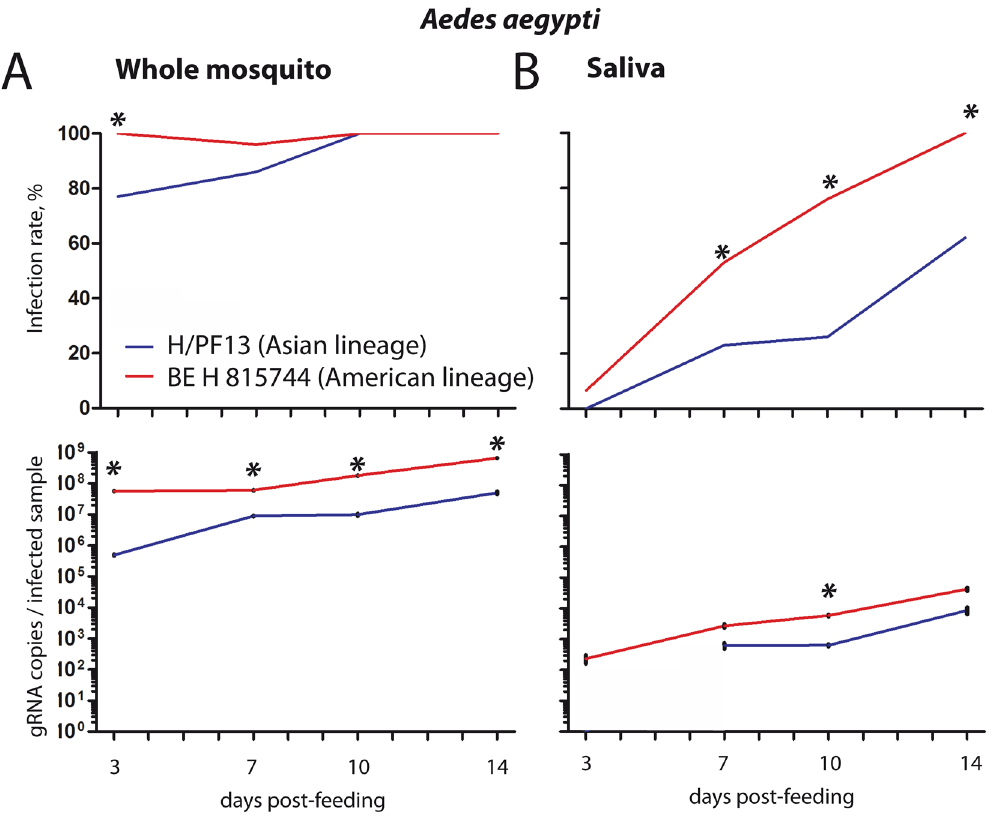
Figure 3. Aedes aegypti mosquitoes infected with a strain from Brazil have a higher infection rate of saliva. Aedes aegypti mosquitoes were orally infected with 10 5 pfu/ml of PF13 or the Brazil virus. At 3, 7, 10 and 14 days p.i., Zika virus genome copies was quantified in ( A ) whole mosquitoes and ( B ) saliva. Percent of infection rate and average ± s.e.m. for genome copies per infected mosquitoes or saliva are presented. Thirty mosquitoes were analyzed per condition. Asterisks show differences between the two viruses within the same day following a Z-Test and T-test for infection rate and gRNA copies,